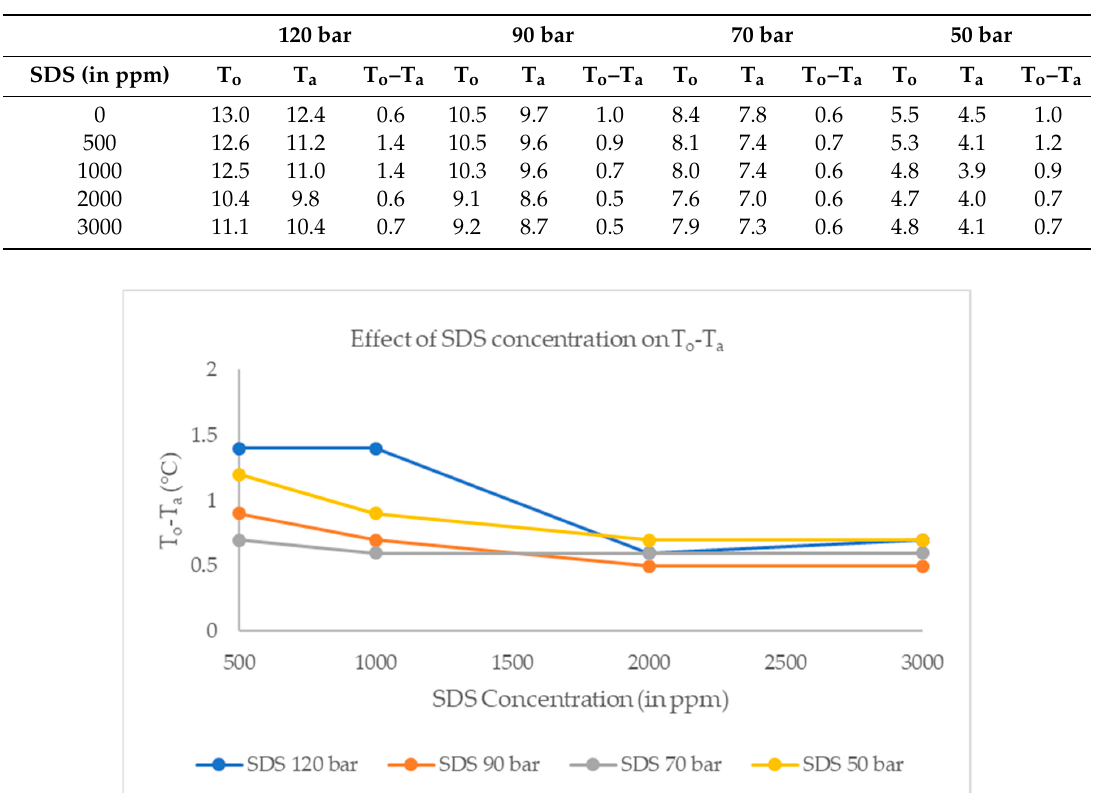
Figure 8. Δ T o –T a at different pressure from 50–120 bar at different SDS concentration for fresh SDS Figure 8. ∆ T o –T a at di ff erent pressure from 50–120 bar at di ff erent SDS concentration for fresh solution. SDS